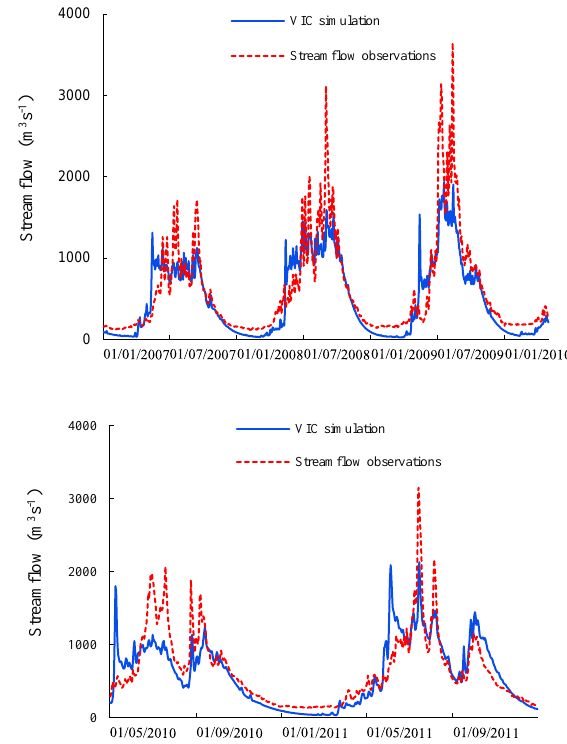
Figure 4. VIC simulated streamflow for the basin in both the cali- bration and validation periods.